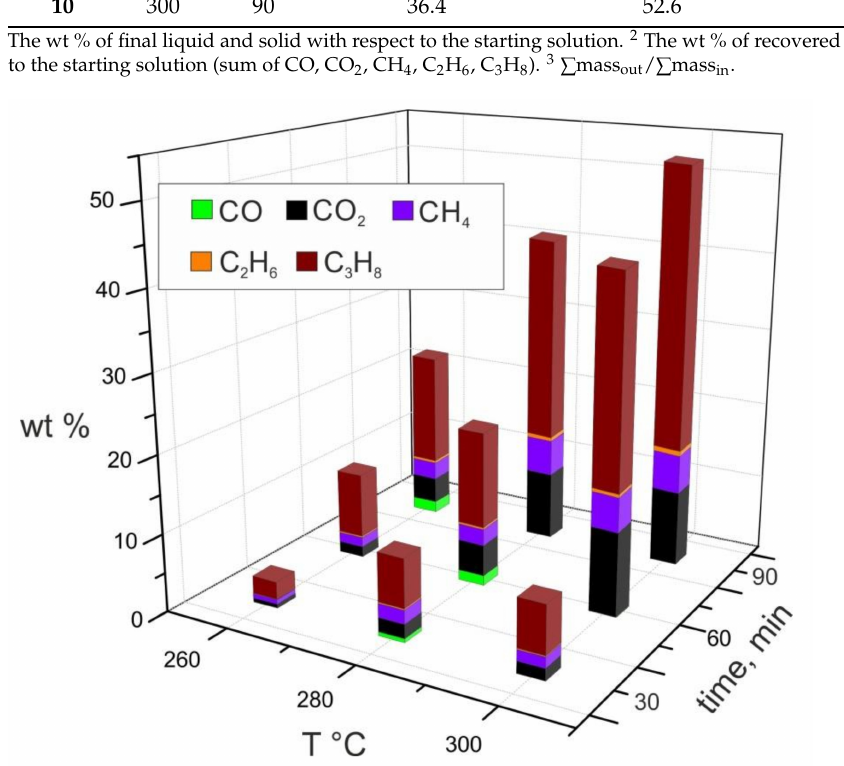
Figure 11. Amount of produced gases at different temperatures and residence